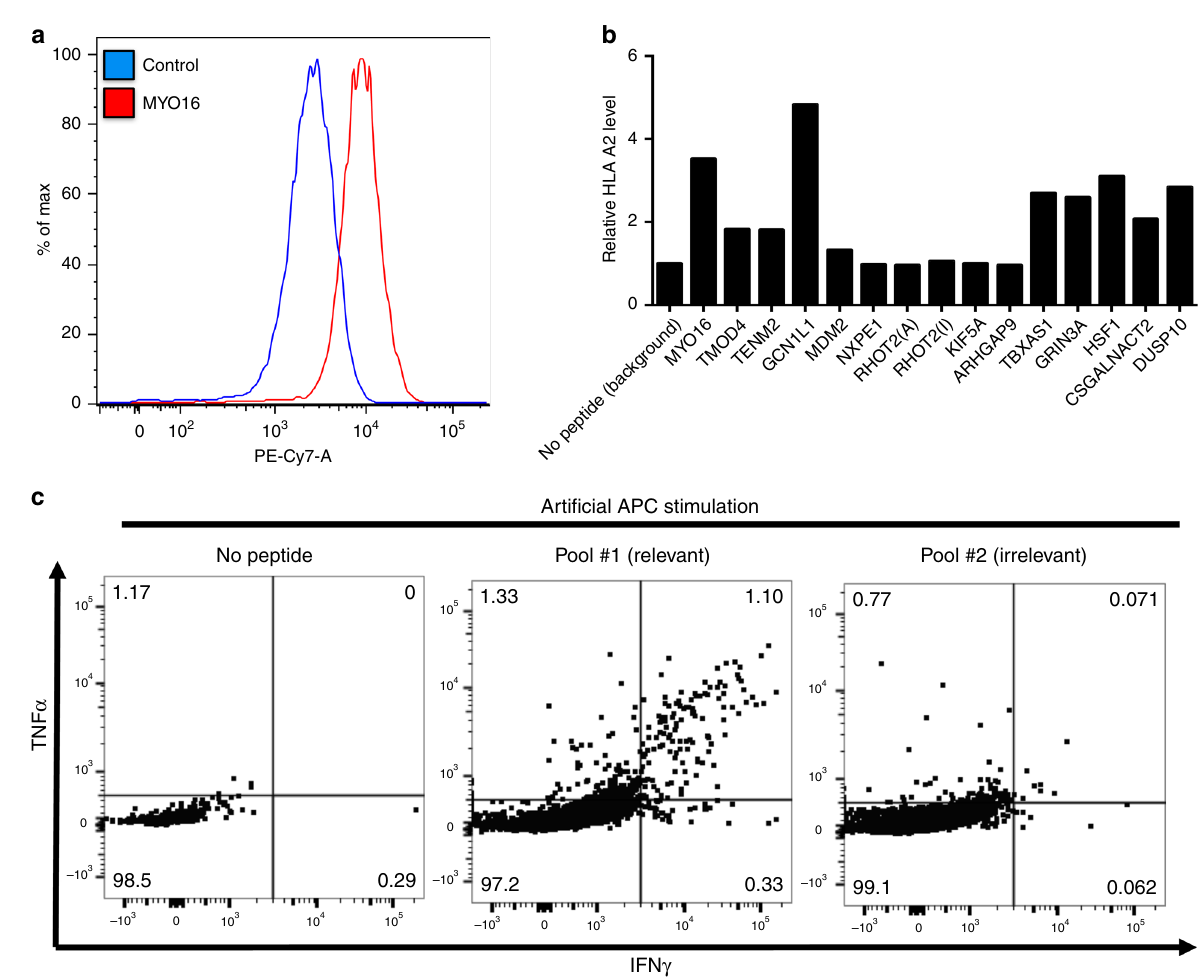
Fig. 2 Experimental validation of predicted MHC class-I neoantigens detected in NSCLC. a Representative fl ow cytometry histogram showing the relative PE-Cy7 fl uorescence of surface HLA-A2 in LCL-174 cells in the control condition (blue) or after incubation with recombinant MYO16 mutant neopeptide (red). ( b ) Distribution of stabilization signal scores for each recombinant neopeptide binding to HLA-A2 protein in LCL-174 cells. Scores are expressed a fold change relative to the signal obtained using the negative control. The data presented correspond to neoepitopes identi fi ed in three different tumor samples from one patient (primary tumor, metastasis, and recurrence). Each score obtained was averaged and a ratio was calculated respect to the average of the negative control peptide signal. Data in ( a , b ) is representative from two individual experiments. c FACS plot showing the levels of intracellular IFN- γ and TNF- α measured by fl ow cytometry in cultured CD8 + T-cells obtained from peripheral blood of the NSCLC patient after stimulation with arti fi cial APCs and no peptide (left panel), a pool containing eight recombinant mutant neopeptides preincubated with mature autologous APCs (pool #1 relevant, center panel) and another pool of six mutant neopeptides not preincubated with autologous APCs (pool #2 irrelevant, right panel). Data in ( c ) is representative from two replicate